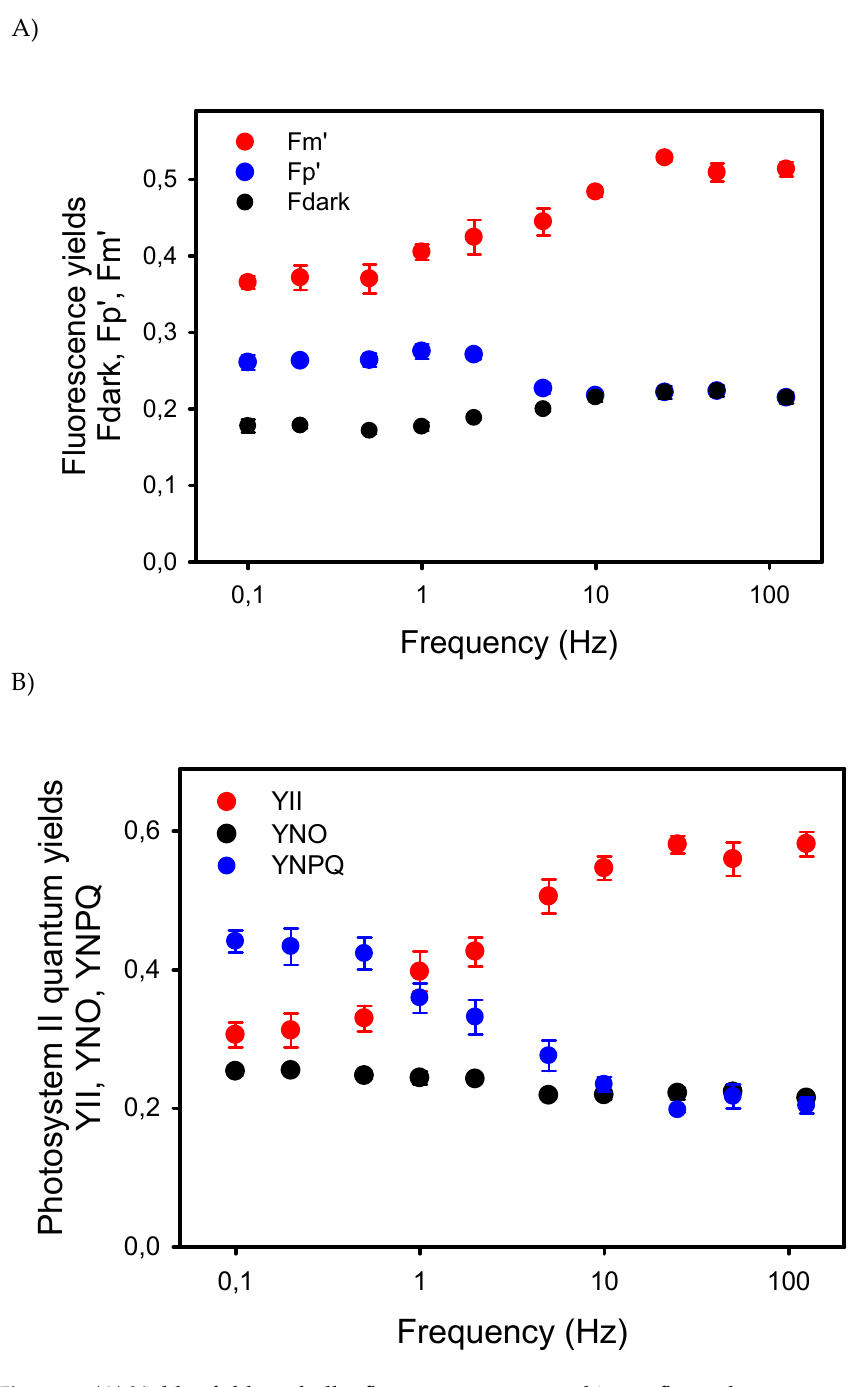
Figure 2. ( A ) Yields of chlorophyll-a fluorescence measured in sunflower leaves exposed to pulsed lights of different frequencies. Fdark represents the mean fluorescence level measured in darkness, i.e., between the light pulses, whereas Fp’ is the peak level of the ChlF reached during the repetitive pulses. Fm’ is the maximum fluorescence level induced by a saturating pulse given just before the end of the 8–10 min period of pulsed light. The Fdark, Fp’, and Fm’ yields are the ChlF values normalized to the maximum ChlF level Fm measured in dark-adapted leaves. ( B ) Effects of the frequencies of pulsed lights on the complementary quantum yields in photosystem II: quantum yield of photochemical energy conversion (YII), and quantum yields of regulated (YNPQ) and nonregulated (YNO) nonphotochemical energy dissipation.